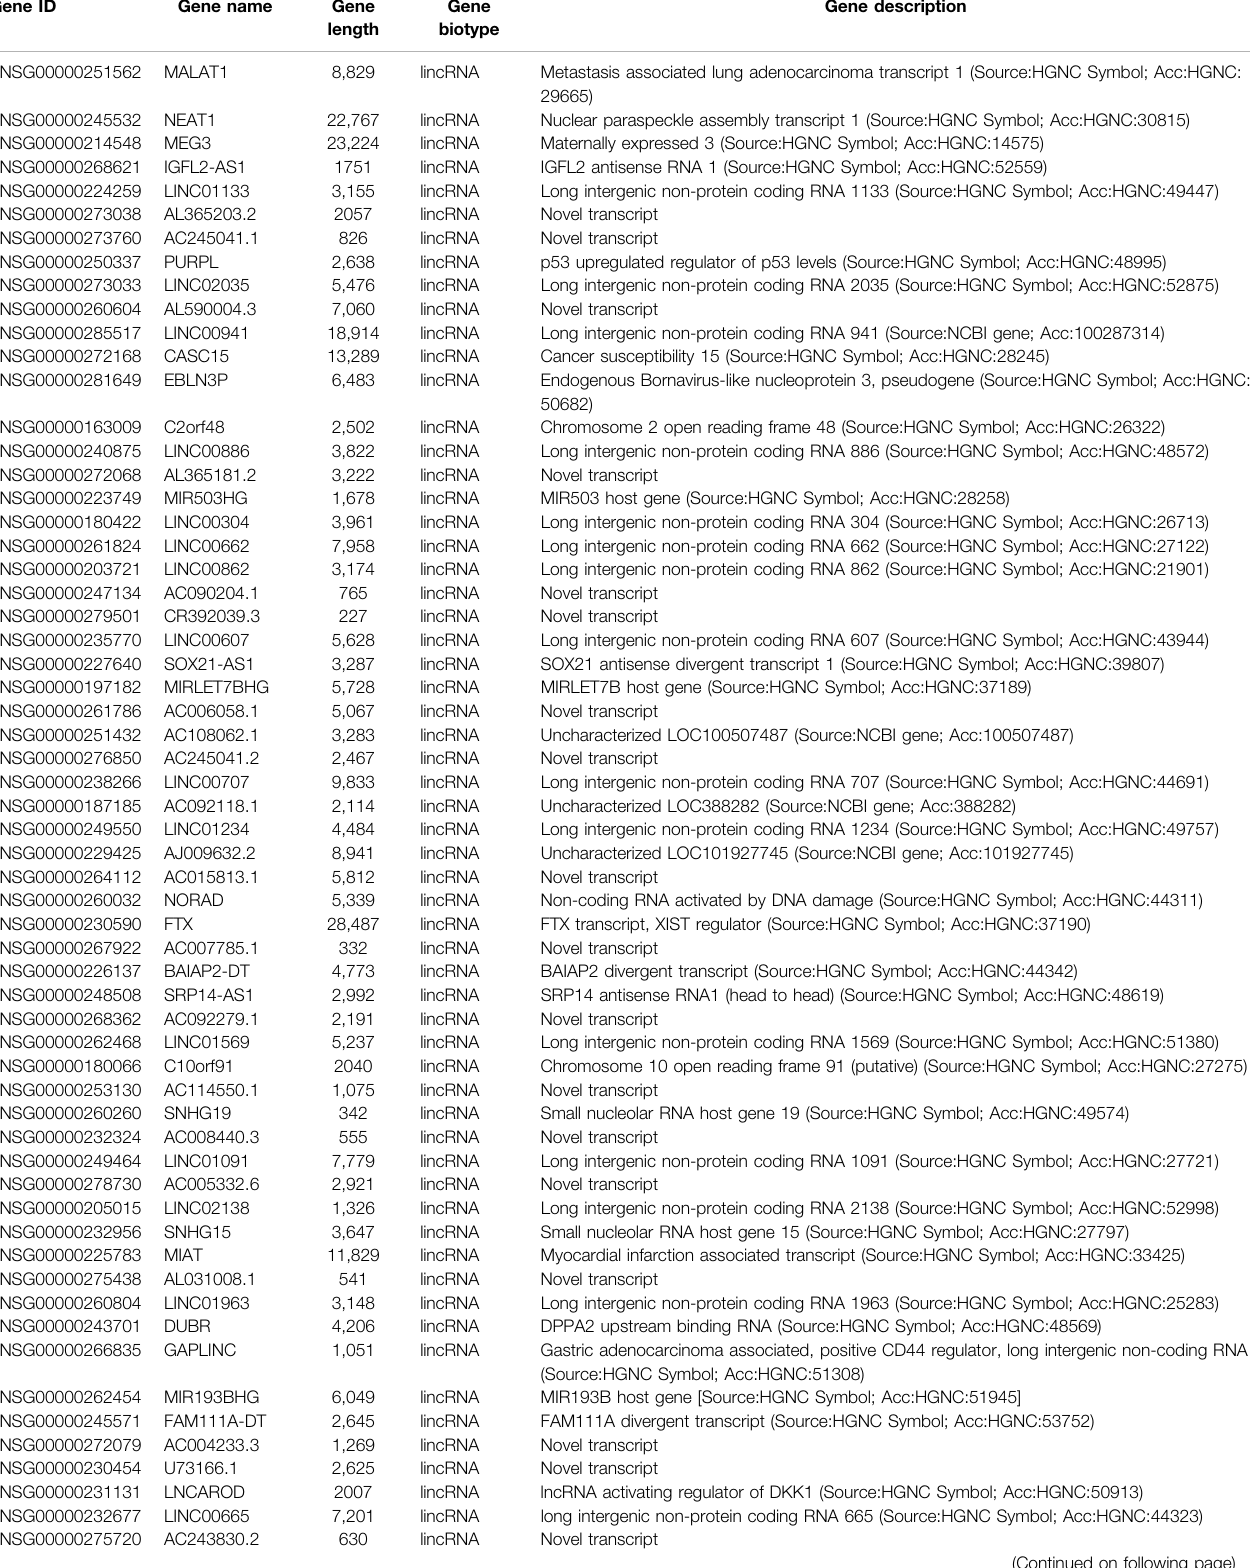
TABLE 2 | All lincRNA changed in HuR Knockdown A549 cell by RNA Sequencing analysis. Gene ID Gene